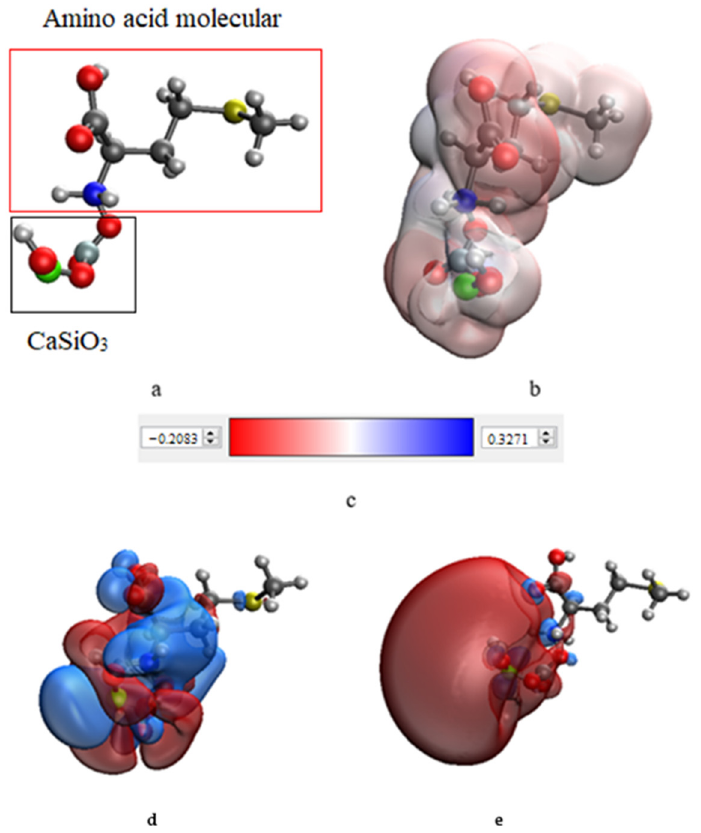
Figure 6. Modeling results for the CaSiO 3 –L–methionine molecular system, in which the interaction occurs through the amino group attached to the C 2 atom of methionine: ( a ) model of the molecular complex, ( b ) electron density distribution, ( c ) electron density distribution gradient, ( d ) highest occupied molecular orbital, HOMO, ( e ) lowest unoccupied molecular orbital, LUMO.